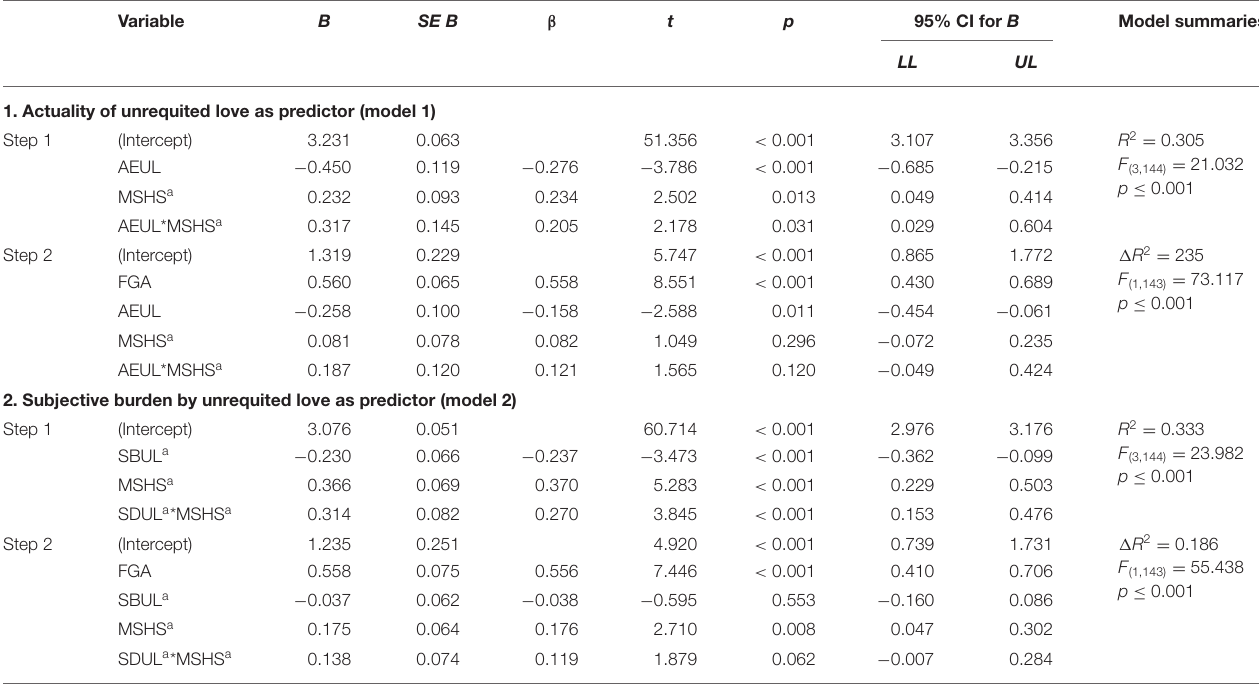
TABLE 3 | Summary of hierarchical regression analyses predicting self-esteem from burden of unrequited love (two different operationalizations) and sense of humor (measured by MSHS). Variable B SE B β t p 95% CI for B Model